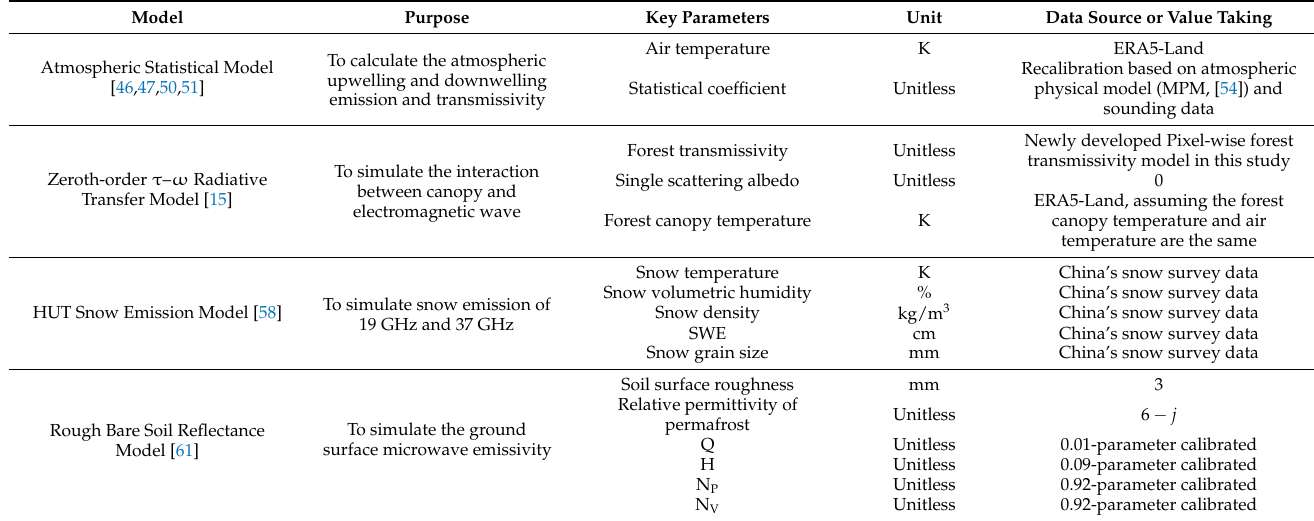
Table 1. Sub-module description and key parameter information of the forward